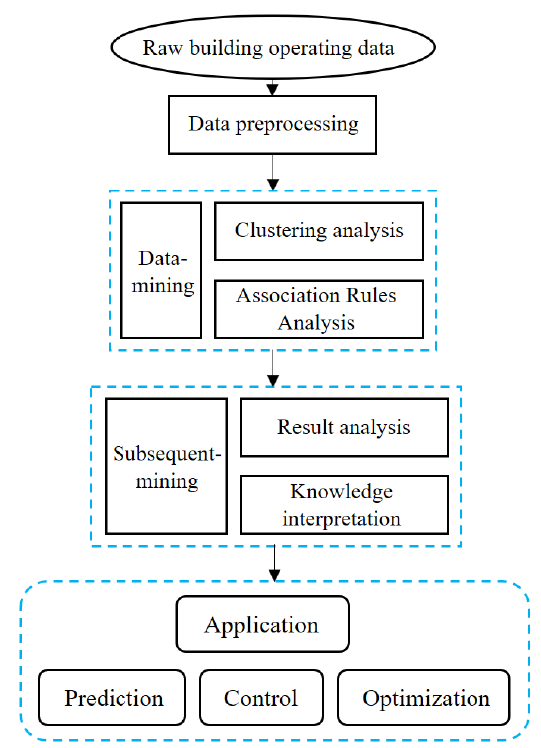
Figure 3. The flow chart of data analytics in building.